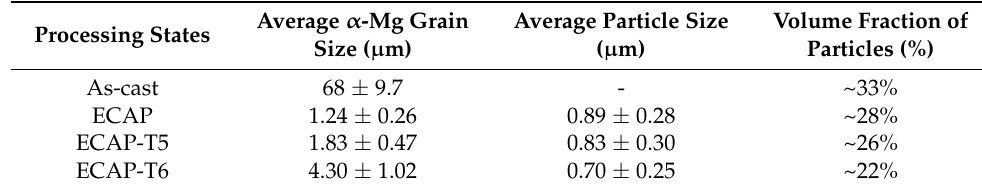
Table 2. Measurements of average α -Mg grain size, average size and volume fraction of second phase particles in alloys with different processing